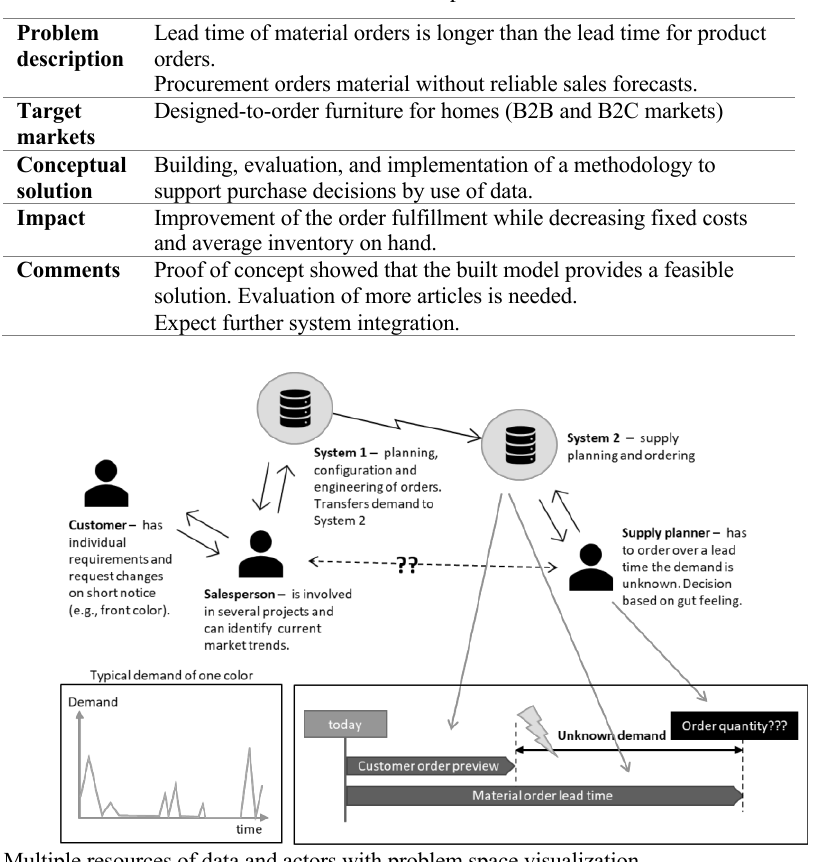
Table 3. Contextual description for case 2 Problem description